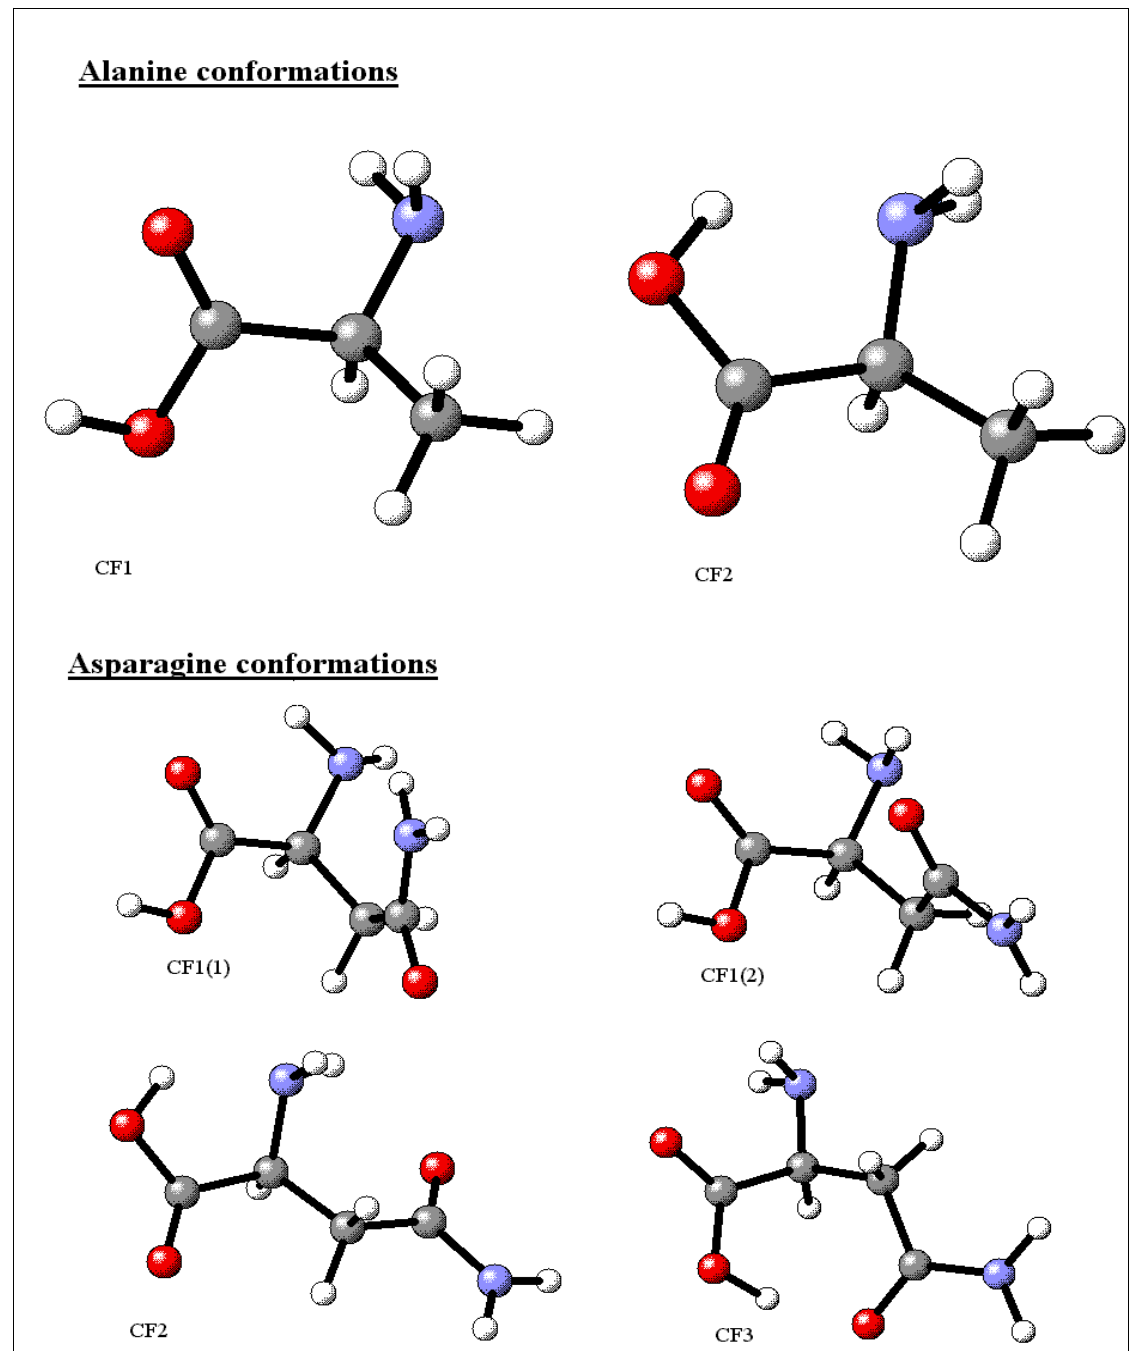
Figure 1 :Ala and Asn optimized